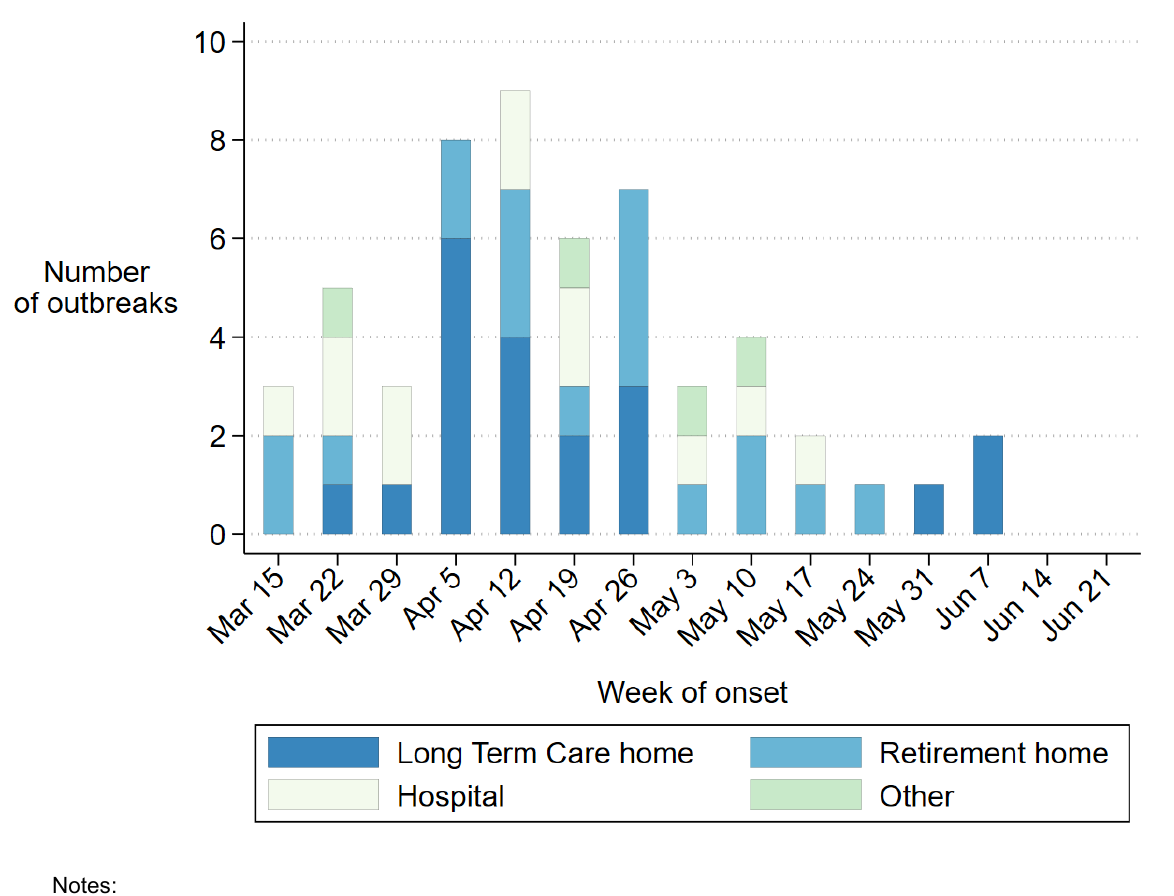
Figure 5: Total number of COVID-19 outbreaks in Ottawa institutions 4